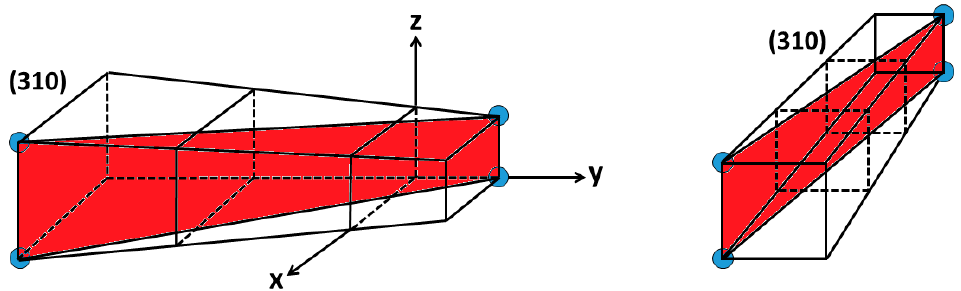
Figure 4. Schematics of (310) expanded in three unit cells.